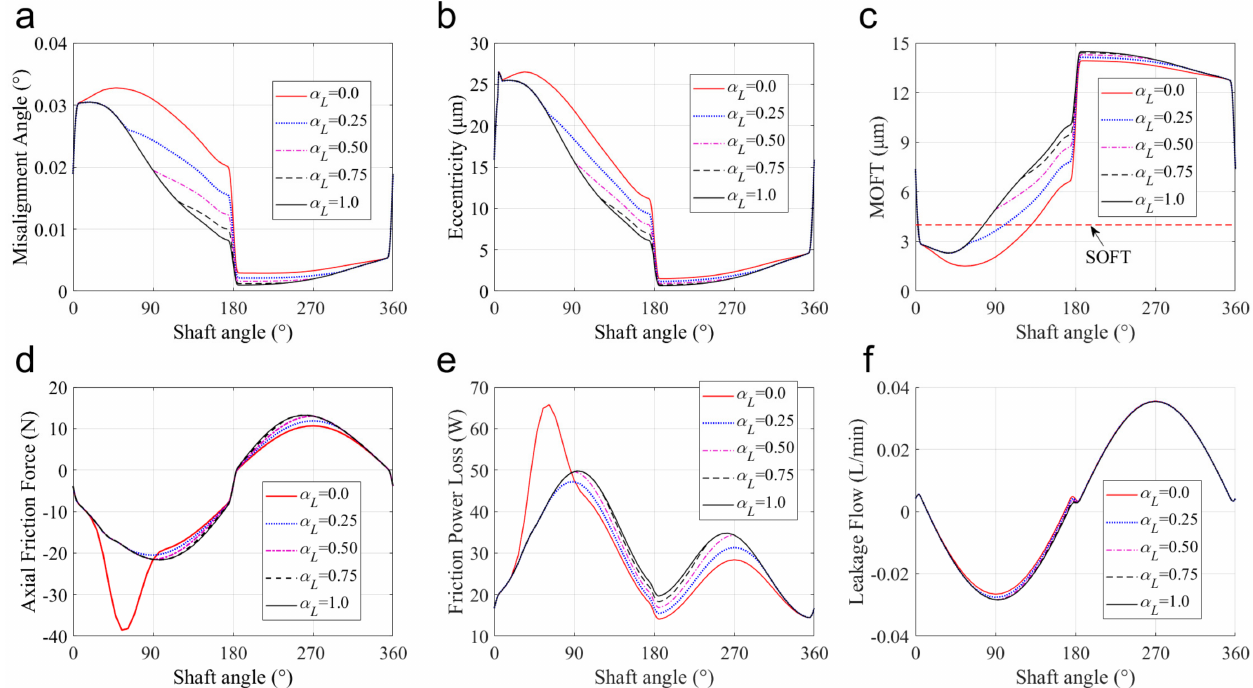
Figure 14. Performances of the pump with different cylinder lengths: ( a ) the misalignment angle, ( b ) the eccentricity, ( c ) the MOFT, ( d ) the axial friction force, ( e ) the friction power loss, and ( f ) the leakage